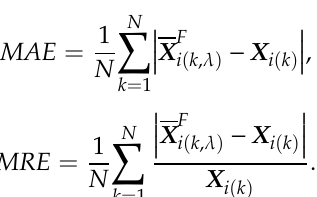
Table 3. Comparison of performance indicators of local measurement fusion estimation, general batch fusion method in each cluster, and global state fusion estimation.